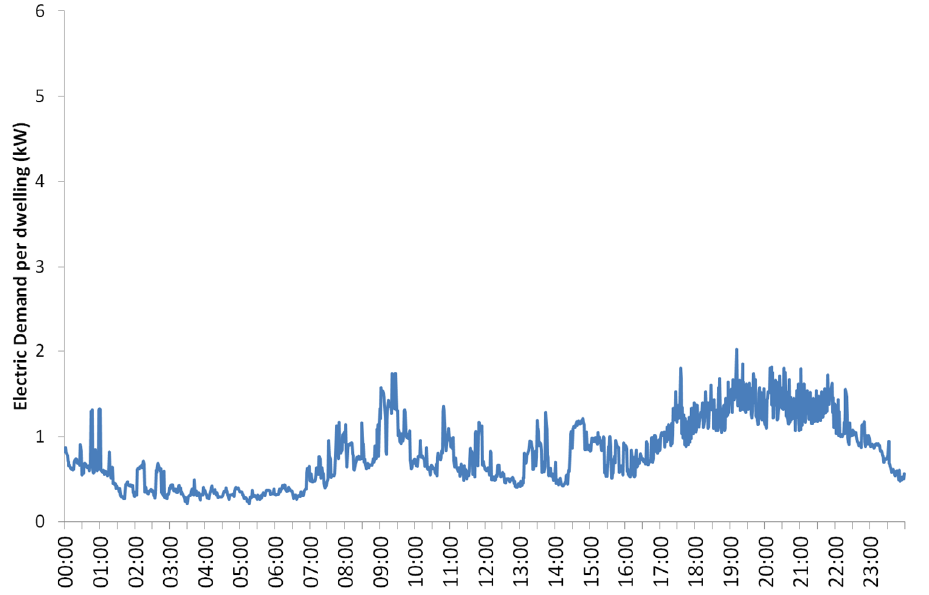
Figure 5. Example of an aggregated electrical demand profile of nine different dwellings at minutely resolution from an empirical dataset